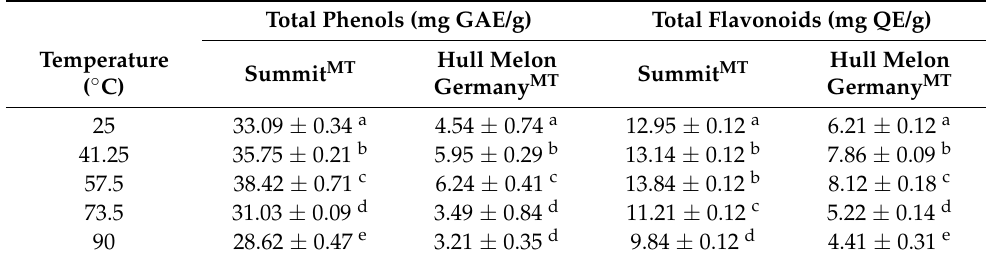
Table 4. Total phenol content (TPC) and total flavonoid content (TFV) of aqueous extracts of two varieties of hops with different content of α